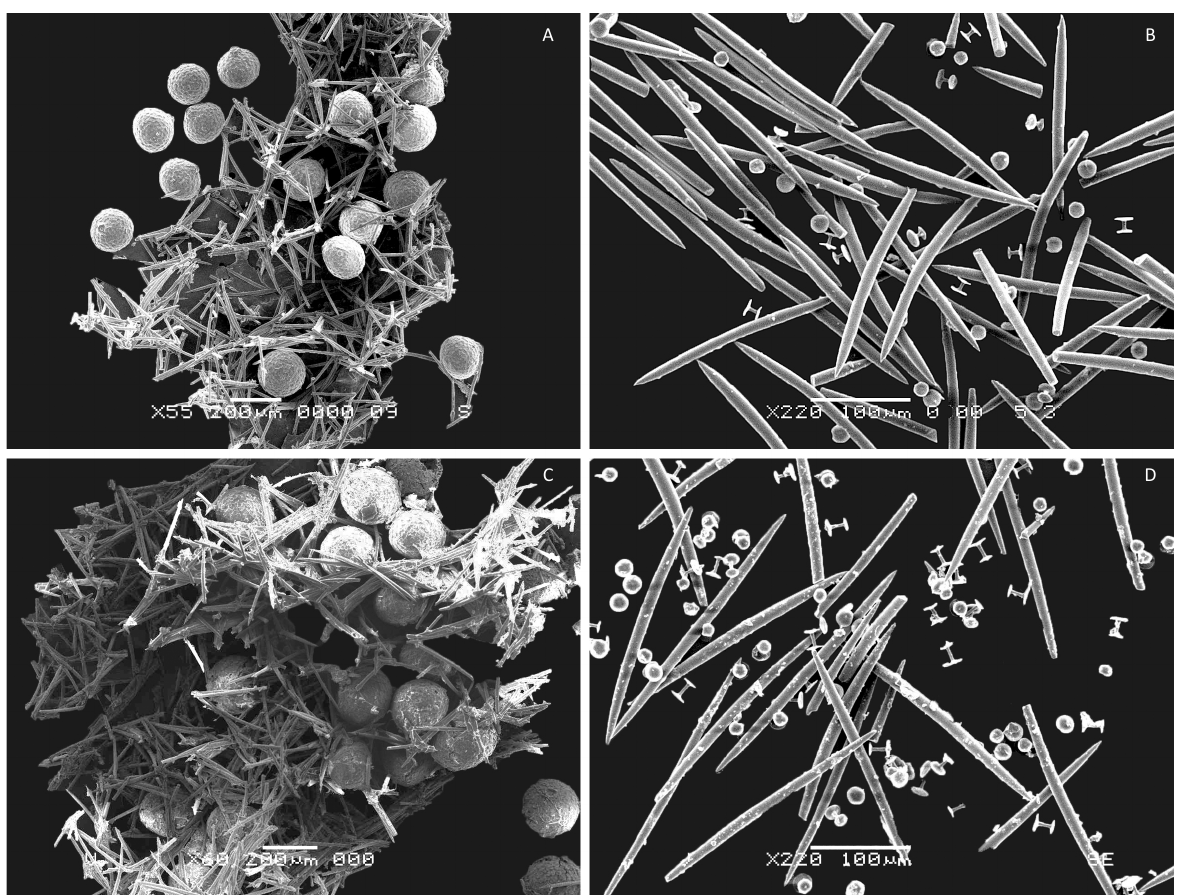
Image 2. SEM images of skeleton with gemmules, megascleres and gemmuloscleres. A - Loose skeleton of T. latouchiana ; B - Megascleres and gemmuloscleres of T. latouchiana ; C - T. latouchiana sinensis spicular skeleton with interspersed gemmules; D - Megascleres and gemmuloscleres of T. latouchiana sinensis . Note the similarity in morphology but overall slenderness of spicules as compared with those of T. latouchiana . © H.V. Ghate, Shriraj S. Jakhalekar & Shinde